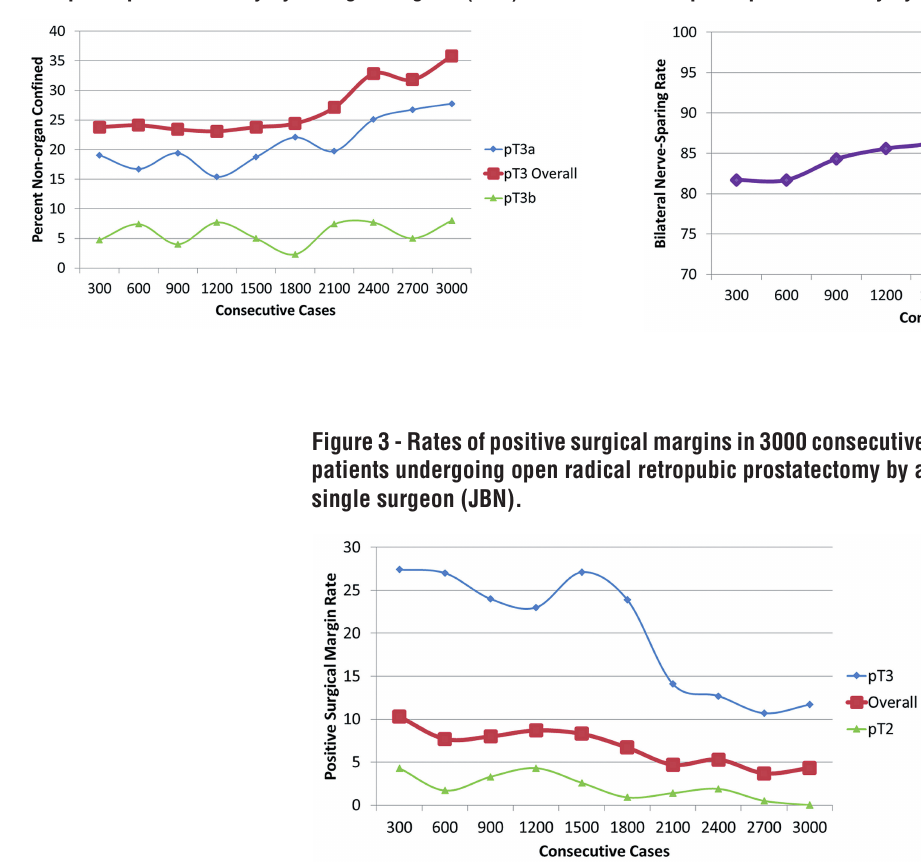
figure 2 - frequency of bilateral nerve-sparing procedures in 3000 consecutive patients undergoing open radical retropubic prostatectomy by a single surgeon (JBn).